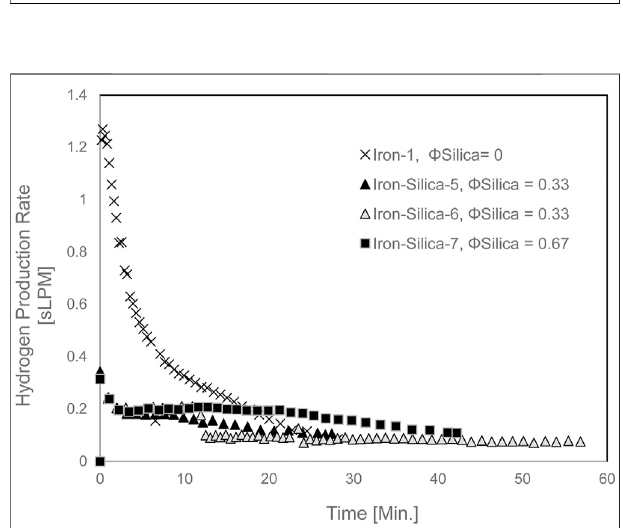
FIGURE 8 | The Hydrogen production rate for mixed iron and silica (0 – 45 µm) with various silica volume fractions at 650 ° C set furnace